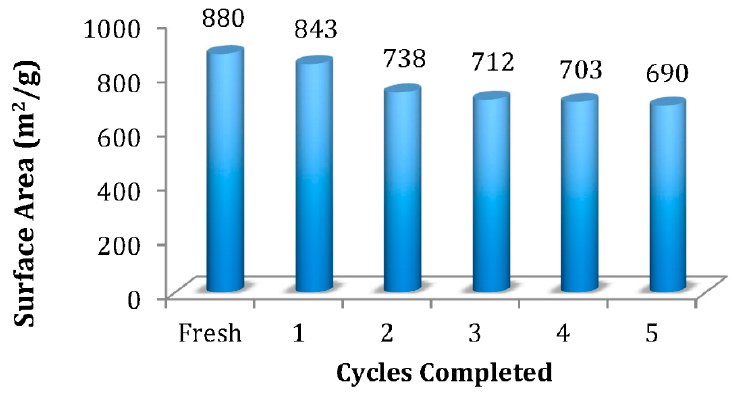
Figure 3. BET measurements of the surface area of OSU-6.